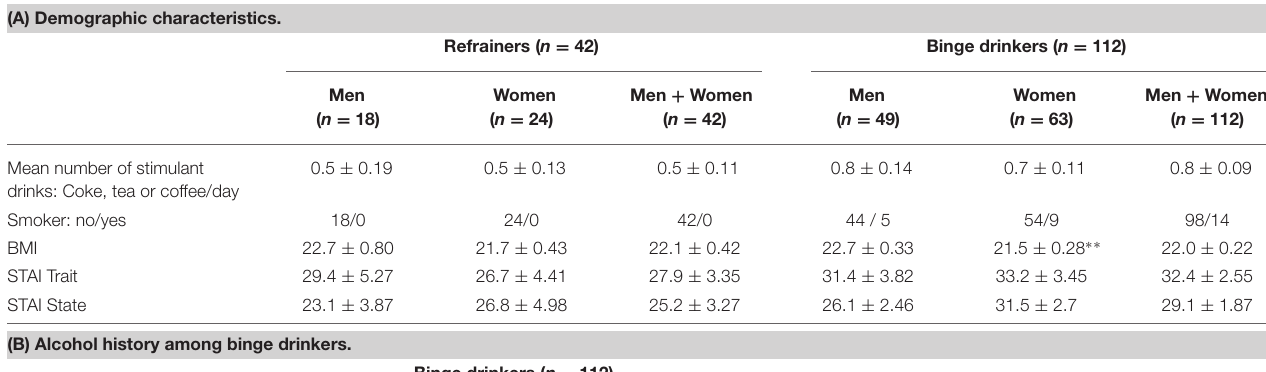
TABLE 1 | Characteristics of the study population. (A) Demographic